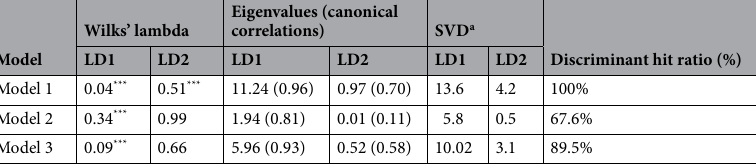
Table 1. Model comparison of linear discriminant analysis. LD1 linear discriminant function 1, LD2 Linear discriminant function 2, Model 1 MMSE + CDR + GDS + B-ADL + I-ADL, Model 2 B-ADL + I-ADL,